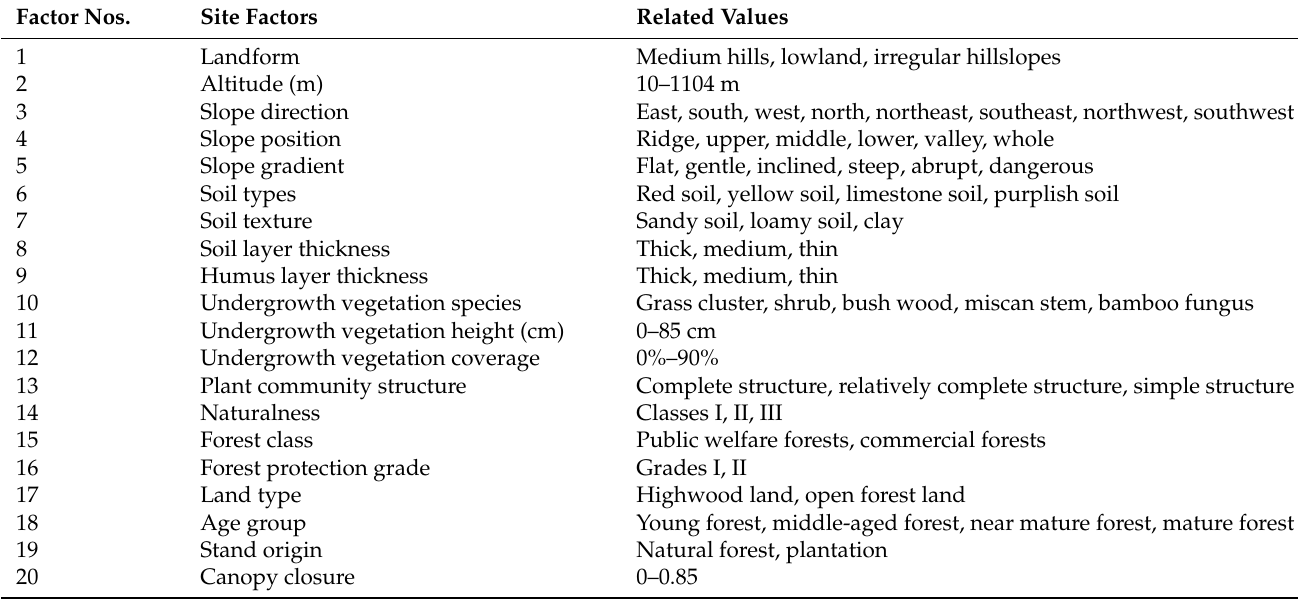
Table 1. The general site information of Chinese fir stands in Lin’an